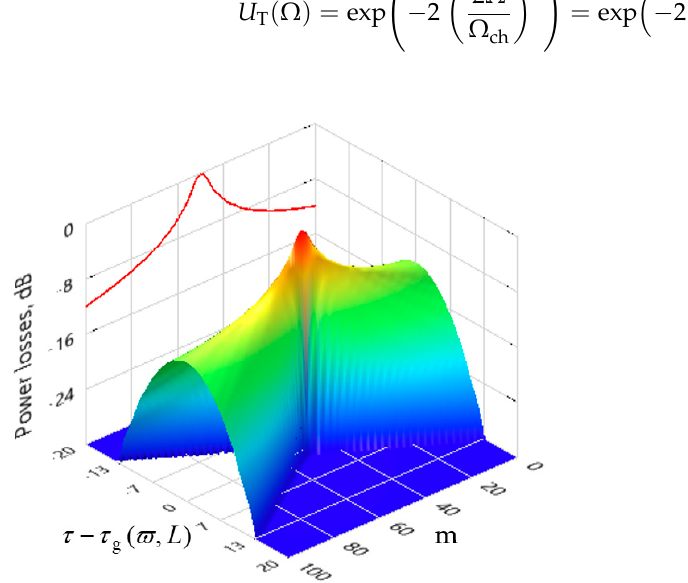
Figure 3. The computing results of the compression of line frequency-modulated pulse with the Gauss form in the fiber with second-order dispersion in dimensionless values. The effect reaches its maximum at communication link length L = 50 ⋅ L e2 , with 10 dB gain